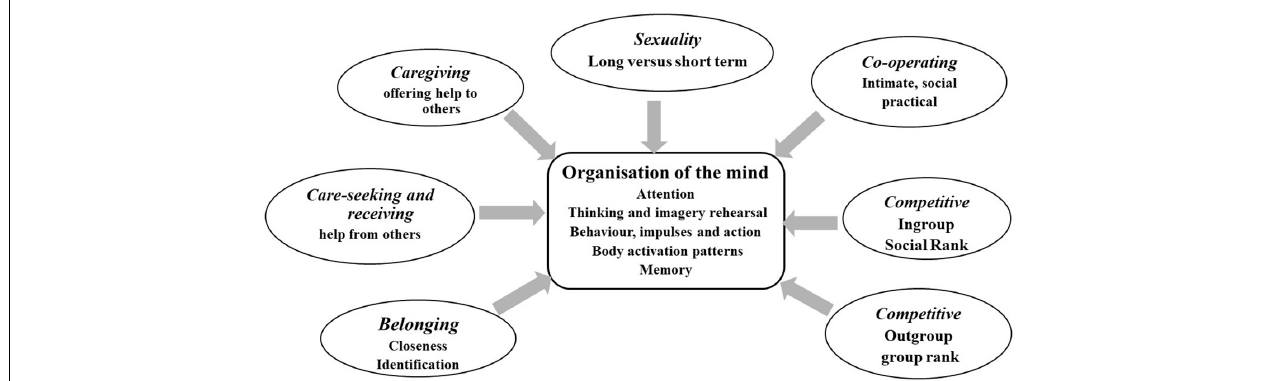
FIGURE 3 | The social mentality organization of